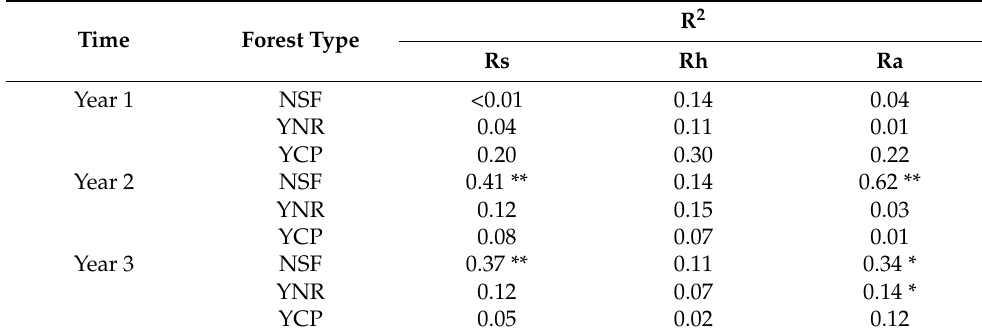
Table 3. The relationship between total soil respiration (Rs), soil heterotrophic respiration (Rh), soil autotrophic respiration (Ra), and soil